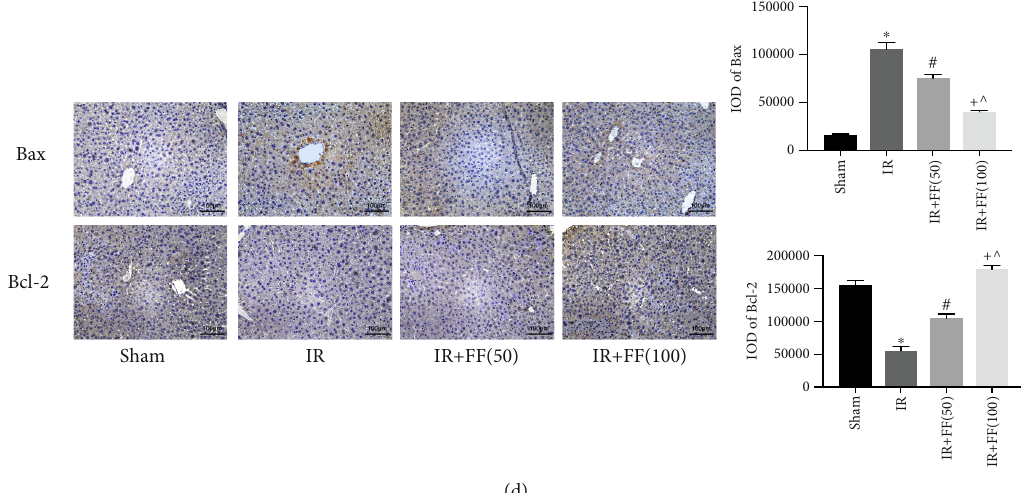
Figure 3: Feno fi brate attenuated IR-induced apoptosis. (a) After 8 h reperfusion, liver tissues were stained by TUNEL and observed under microscopy (magni fi cation, 200x). Final evaluations were made using Image-Pro Plus 6.0 software to calculate the percentage of positive cells. (b) Relative Bax, Bcl-2, Caspase-3, and Caspase-9 mRNA levels were determined by qRT-PCR. (c) Western blot analysis of Bax, Bcl-2, cleaved Caspase-3, and cleaved Caspase-9 levels. The western blot results were quanti fi ed with ImageJ 8.0 software. (d) Bax and Bcl-2 protein expressions in liver tissues at 8 hours after reperfusion are shown by immunohistochemical staining (200x). Final evaluations were made using Image-Pro Plus 6.0 software to calculate the IOD of the positive staining area. Data are presented as mean ± SD ( n = 6 ; ∗ P < 0 : 05 for IR vs. sham; # P < 0 : 05 for IR+FF (50) vs. IR; + P < 0 : 05 for IR+FF (100) vs. IR; ^ P < 0 : 05 for IR+FF (50) vs. IR+FF (100)) (reproduced from Ji et al.